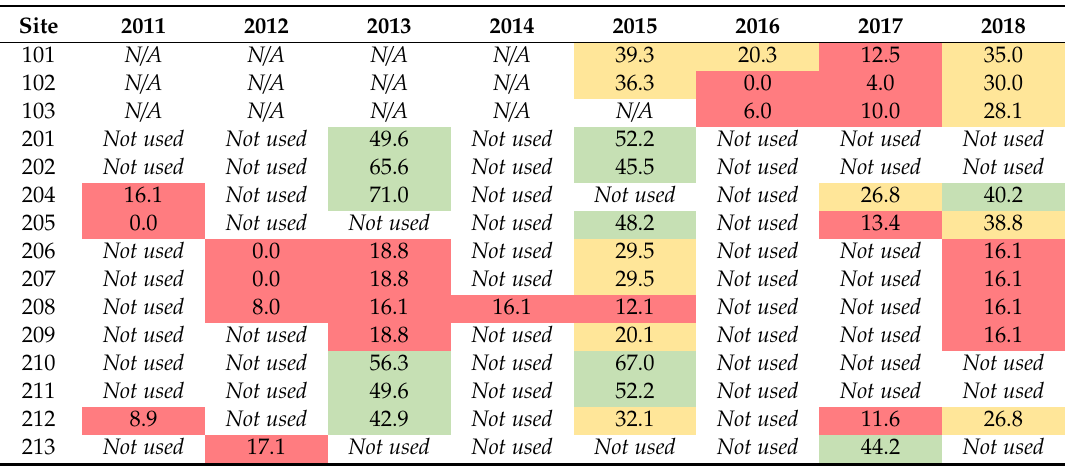
Table 1. Summary of honey harvest data by site and year.